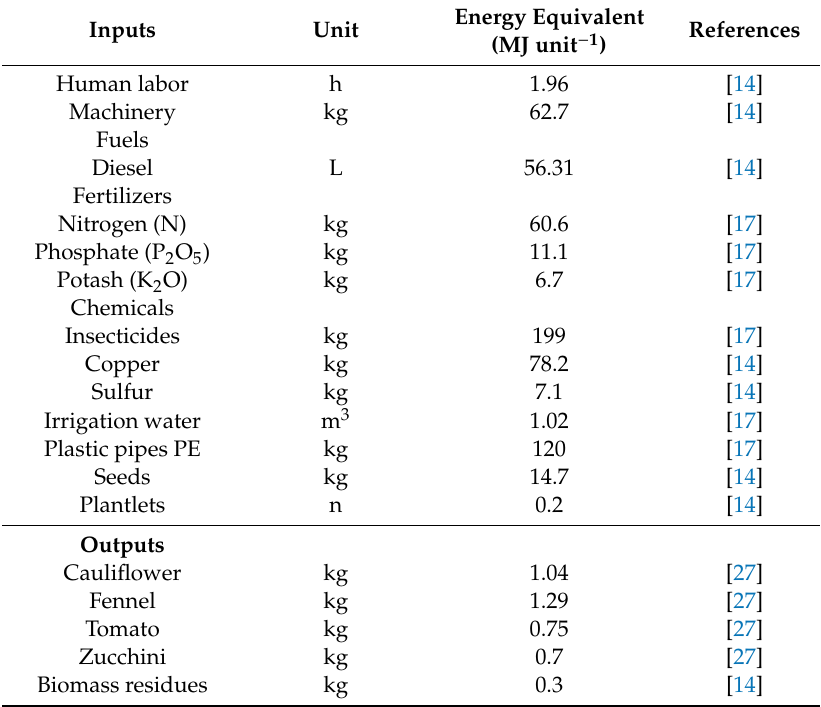
Table 2. Energy equivalents (MJ unit − 1 ) of farm facilities for crops production.